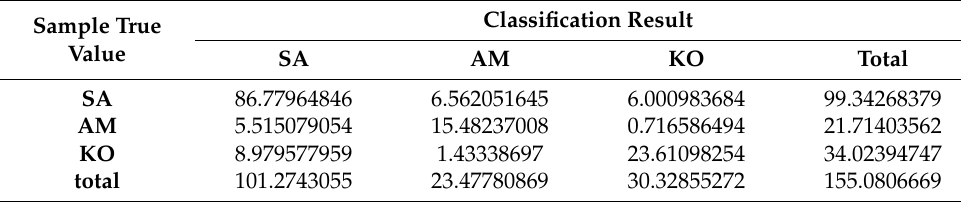
Table 8. Spatial transfer matrix of random forest algorithm (Area unit: